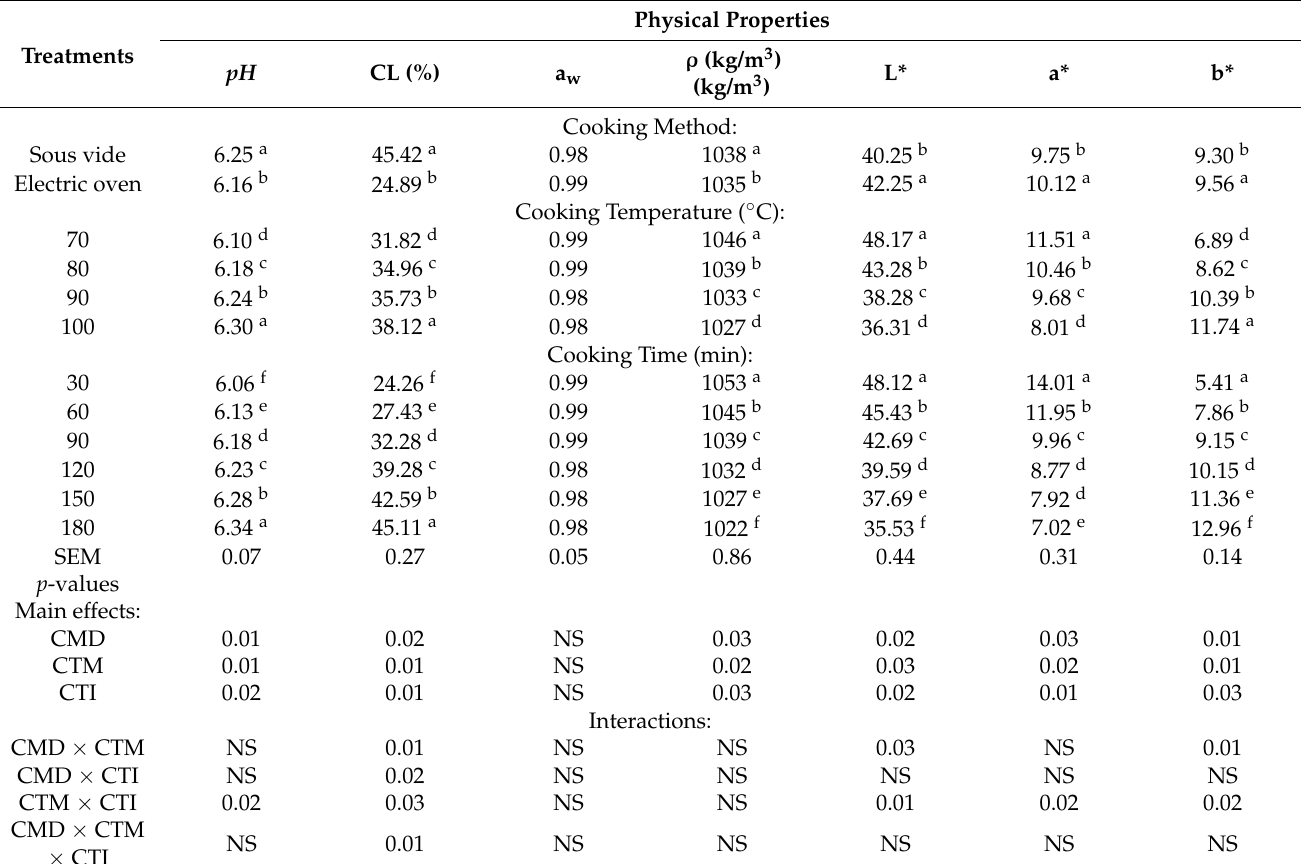
Table 2. Effects of the cooking method (CMD) at different cooking temperatures (CTM) and cooking times (CTI) on the physical properties of camel